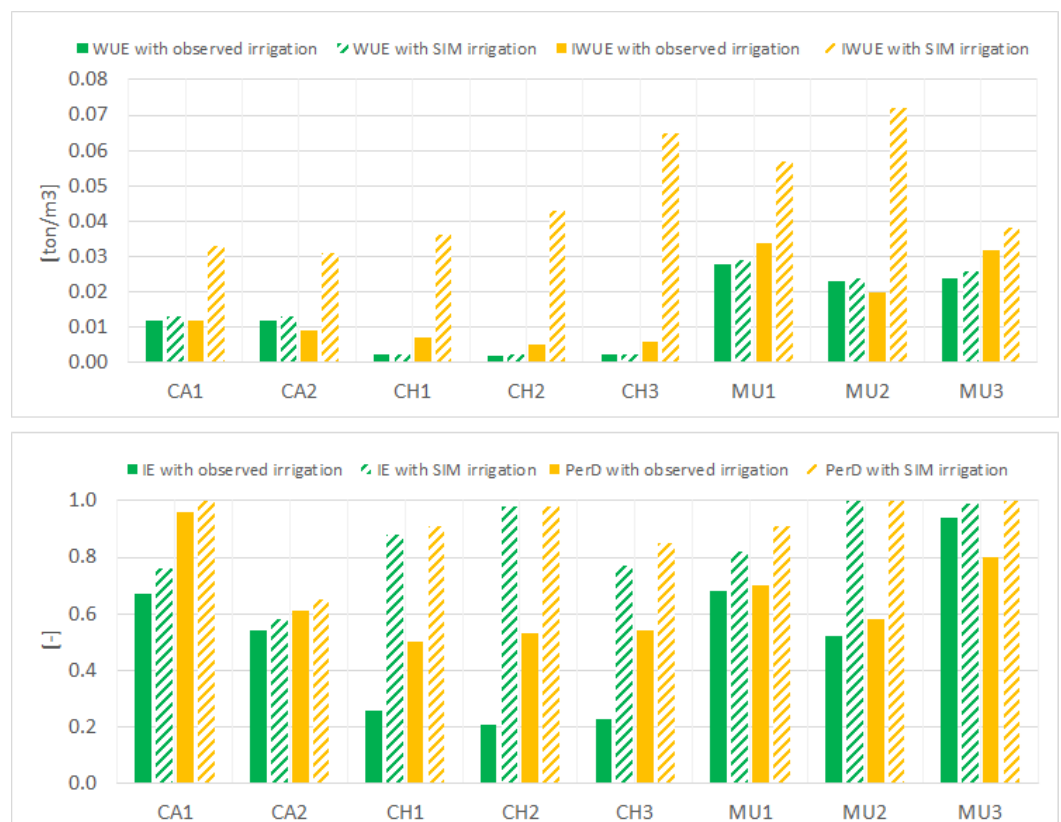
Figure 9. Summary indicators for all case studies: (top) Water use efficiency (WUE) and irrigation water use efficiency (IWUE), (bottom) Percolation deficit (PerD) and irrigation efficiency (IE).